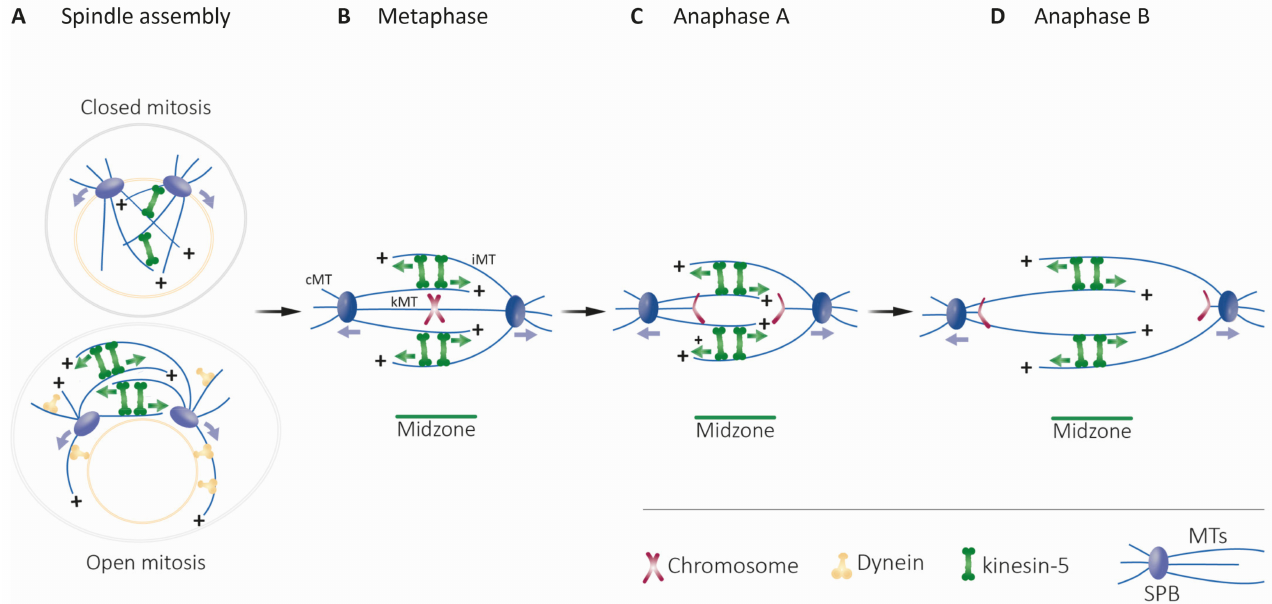
Figure 1. Major roles of kinesin-5 motors in mitotic spindle dynamics (adapted from [10]). ( A ) Separation of spindle poles during spindle assembly in closed (top) and open (bottom) mitosis [11]. Kinesin-5 motors mediate spindle pole-separation by crosslinking and sliding apart anti-parallel spindle MTs. Dynein, the minus-end-directed motor (yellow shape) contributes to spindle assembly in open mitosis [12,13]. Green and purple arrows indicate the direction of movement of the kinesin-5 motors and the spindle poles, respectively. ( B ) Metaphase: chromosome congression takes place at the middle of the bipolar spindle. Different types of MTs are indicated: kinetochore MTs (kMTs), astral or cytoplasmic MTs (cMTs) and interpolar MTs (iMTs). At metaphase, the chromosomes contain pairs of sister chromatids that are attached via their kinetochores to kMTs. Kinesin-5 motors stabilize the spindle by crosslinking anti-parallel iMTs of the mid-zone (indicated at the bottom). In metazoans, kinesin-5 motors maintain spindle bipolarity and drive poleward flux [14–16]. ( C ) Anaphase A. The onset of anaphase A. When cohesion between sister chromatids is lost, the sister chromatids are separated and migrate to the opposite spindle poles. In parallel, poleward flux-based depolymerization of kMTs takes place. ( D ) During anaphase B spindle elongation, the two spindle poles are further separated by an elongating spindle. Such elongation is mediated by cortical forces generated, for example, by dynein motors attached to the cortex which translocate along cMTs. Additional force is provided by kinesin-5-motors by sliding apart anti-parallel iMTs at the spindle